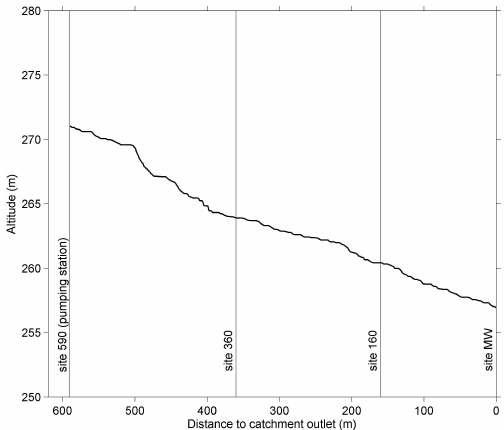
Fig. 3. Longitudinal section of the stream in the HOAL catchment with measurement